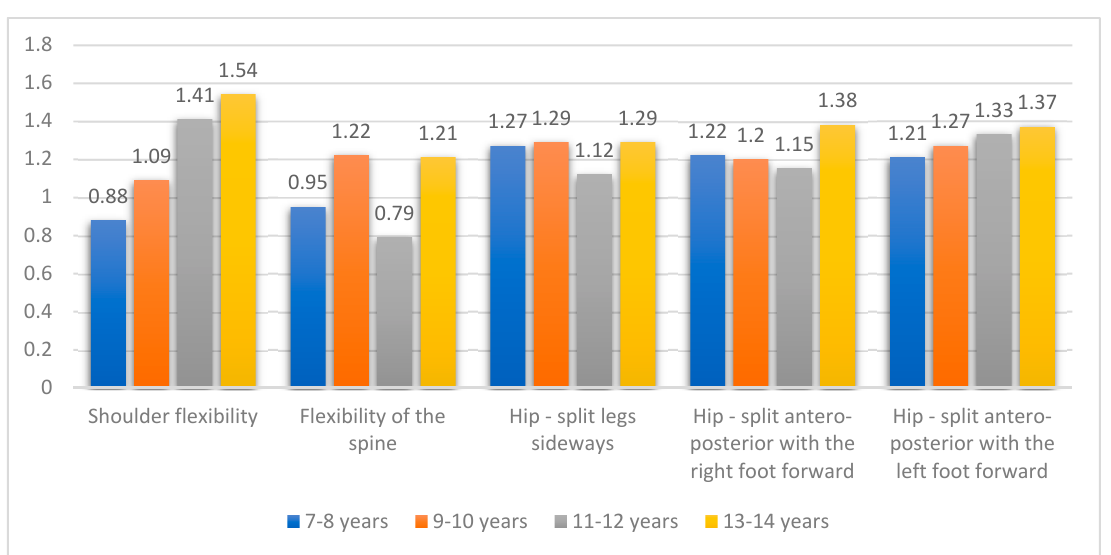
Figure 1. Evolution of segmental flexibilities related to the age groups.